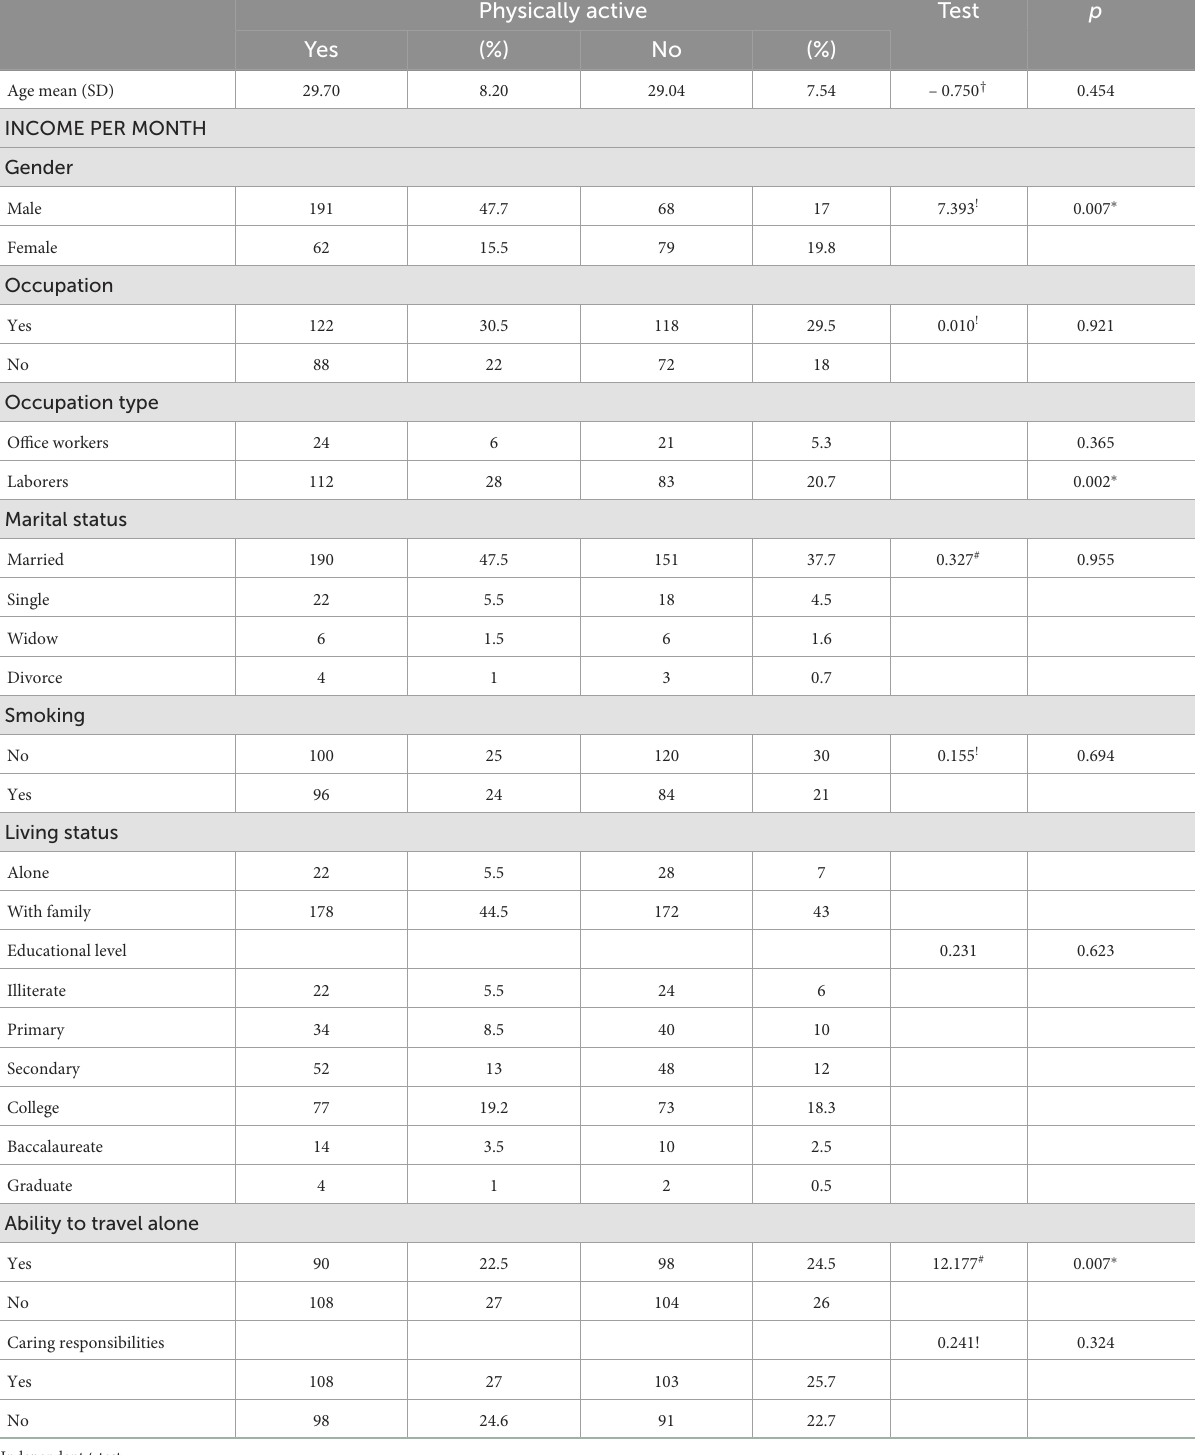
TABLE 3 Association between participants’ sociodemographic characteristics and physical